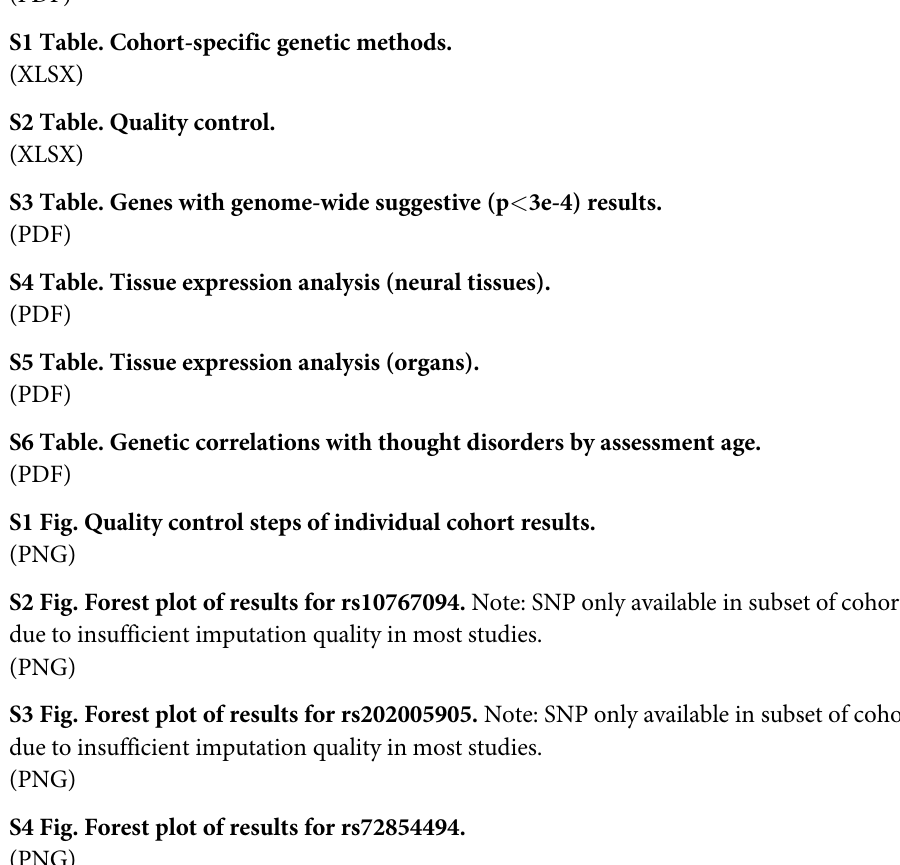
S5 Fig. QQ-plots gene-based analysis. Quantile-quantile plot of observed -log 10 p values vs expected -log 10 p values assuming chance findings in gene based analysis. Diagonal line indi- cates a p value distribution compatible with chance finding. Upward deviations indicate p val- ues more significant than expected. S6 Fig. Manhattan plot gene-based analysis. Manhattan plot of -log 10 p values vs SNP posi- tion for gene based analysis. Genes above the red horizontal line indicate genome-wide signifi- cant